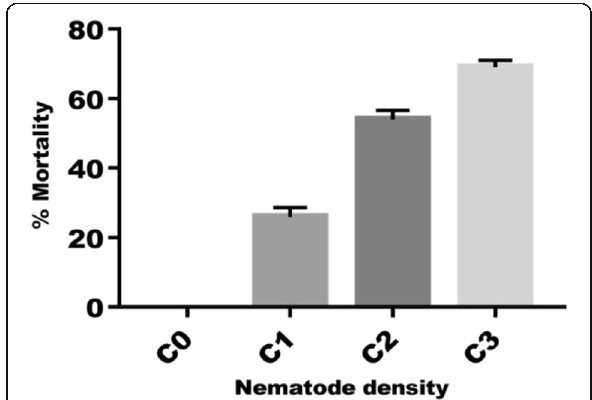
Fig. 4 M ο rtality percentage (mean ± SEM) ο f Ceratitis capitata adults treated with different c ο ncentrati ο ns ο f Steinernema